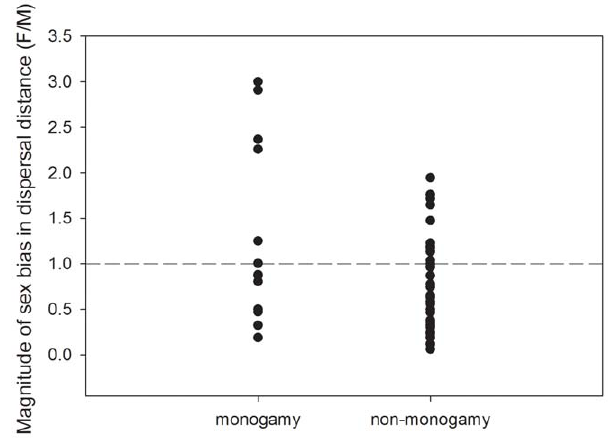
Figure 7. Magnitude of the sex-bias in dispersal distance in mammals, by mating system (socially monogamous or not).